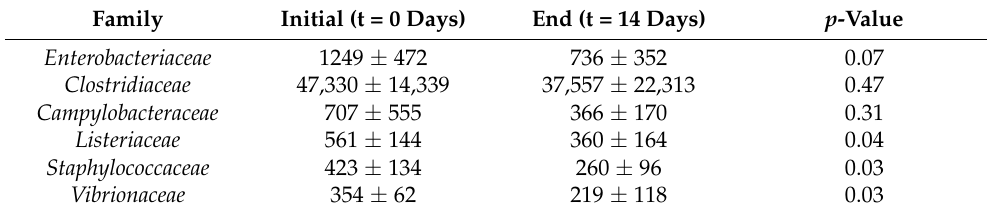
Table 5. Abundance of pathogenic bacteria between the beginning (t = 0 days) and end (t = 14 days) of the study in rats with lees supplementation. Values are mean ± standard